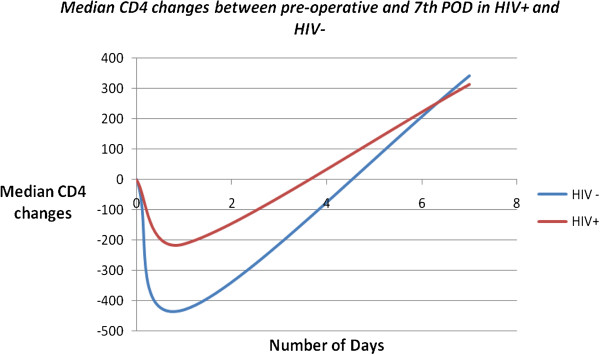
Median CD4 changes from pre to 7th POD.